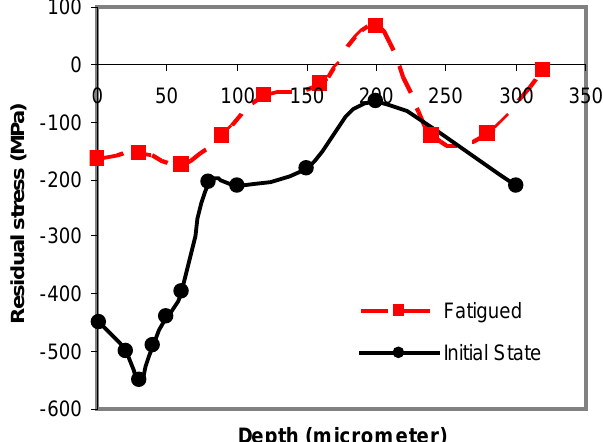
Figure 6: Residual stress depth profiles of shot peened (Almen intensity 0.175 mmA) AISI 304 before and after cyclic loading with MPa 320 =σ after N f /2 cycles [62]. a